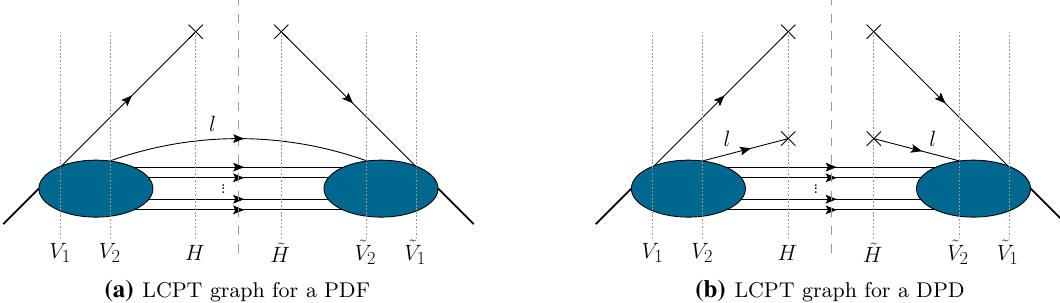
Fig. 7 LCPT graphs for a PDF or a DPD. It is understood that the subgraphs denoted by blobs are identical in panels (a) and (b). One may interchange the time ordering between the vertices V 1 and V 2 , and independently the time ordering between the vertices ˜ V 1 and ˜ V